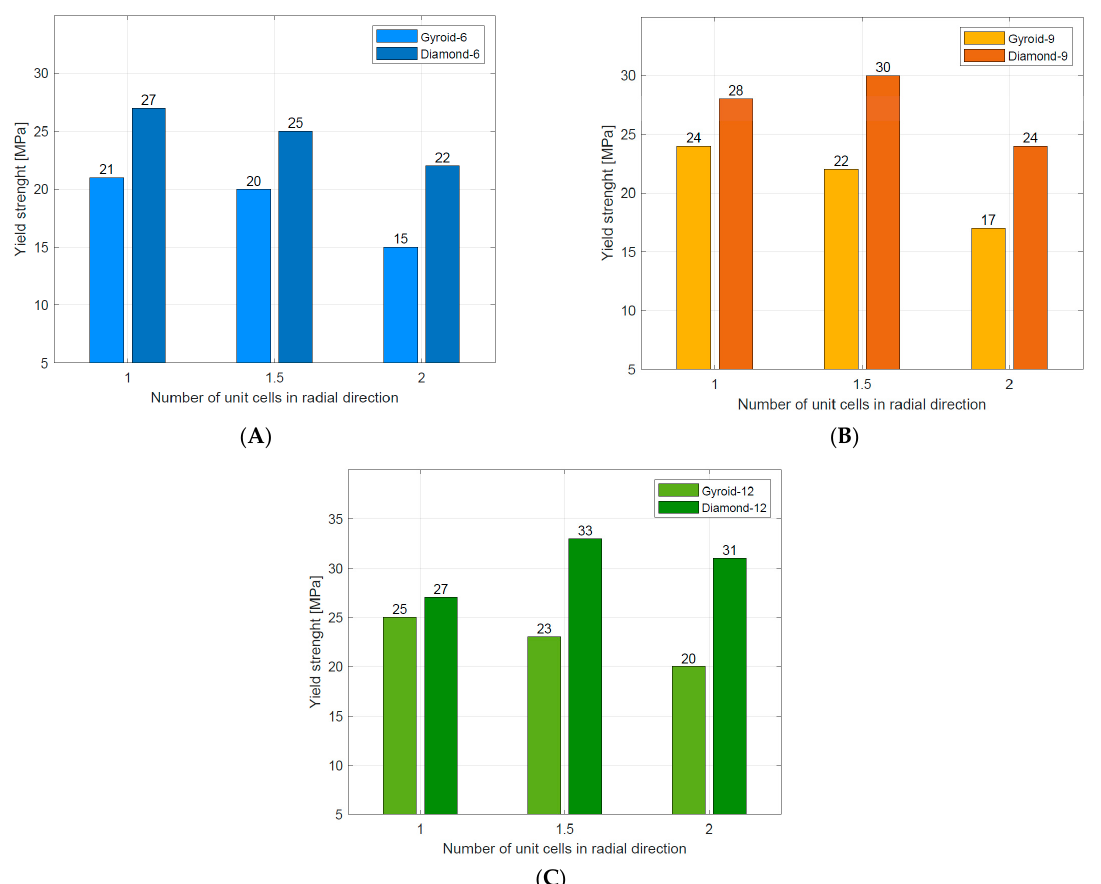
Figure 15. Comparison of yield strength for Gyroid [49] and Diamond TPMS cylindrical structures with ( A ) n circum = 6; ( B ) n circum = 9; ( C ) n circum = 12.